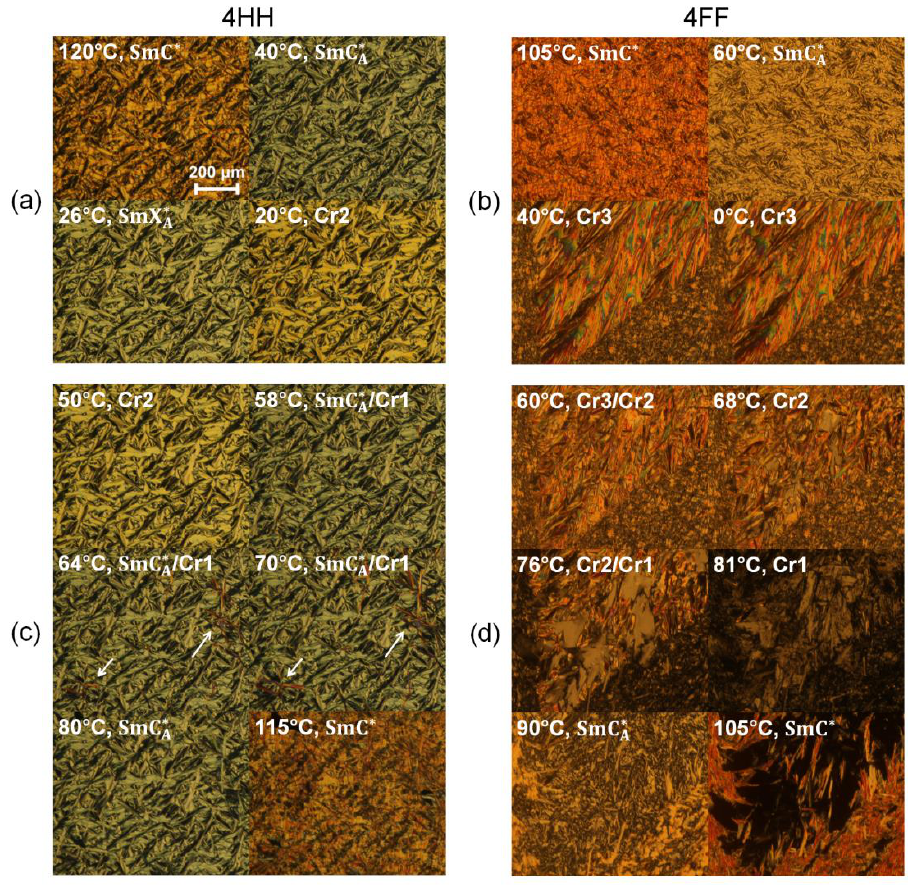
Figure 2. POM textures registered during cooling ( a , b ) and heating ( c , d ) at 6 °C/min rate for 4HH ( a , c ) and 4FF ( b , d ).